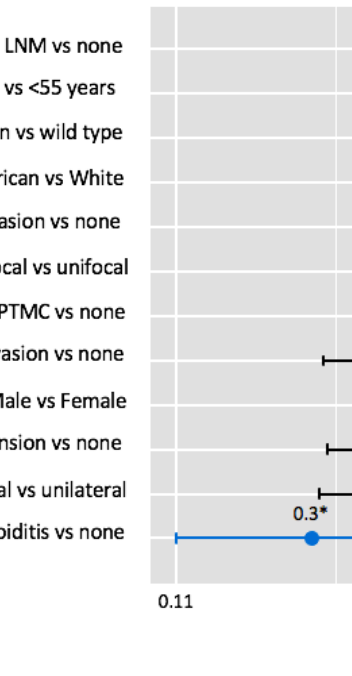
Figure 1. Multivariate logistic regression analysis determining independent predictors of recurrence; * indicates p < 0.05.